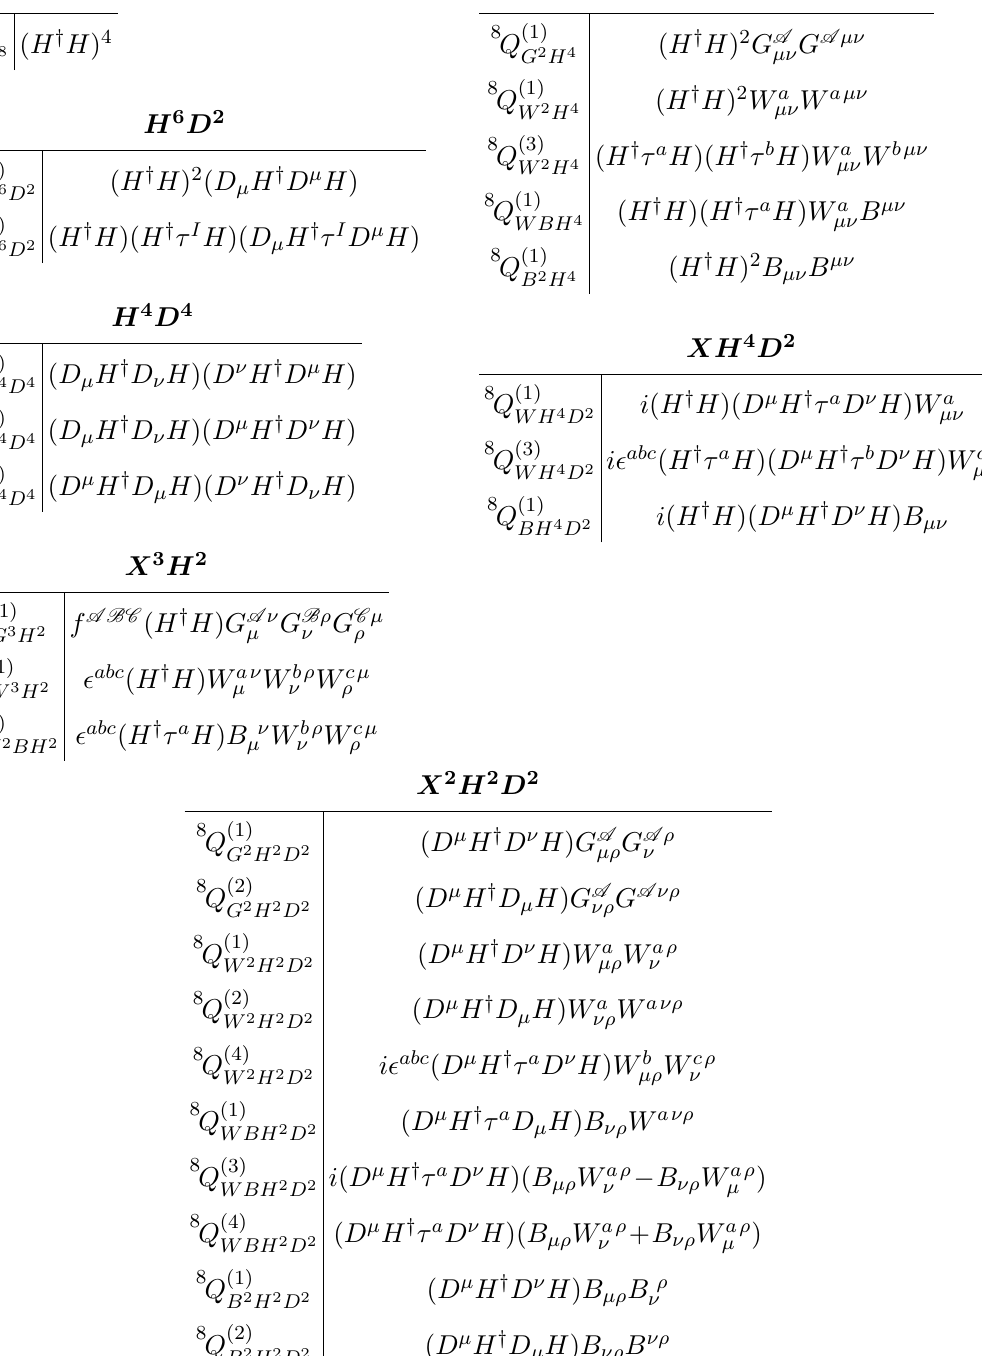
Table 4 . Bosonic dimension-eight operators in the SMEFT. The XH 4 D 2 operators have a factor of i relative to ref. [27] to make them hermitian. There are also X 4 operators which have not been listed